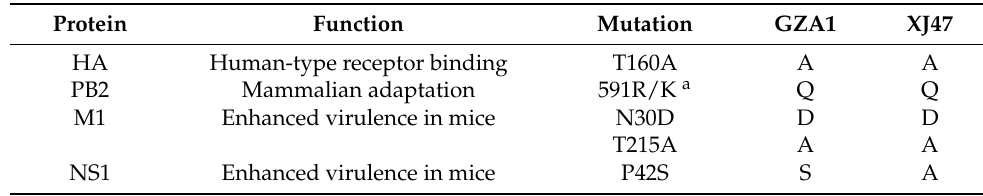
Table 2. Molecular characteristics of GZA1 and